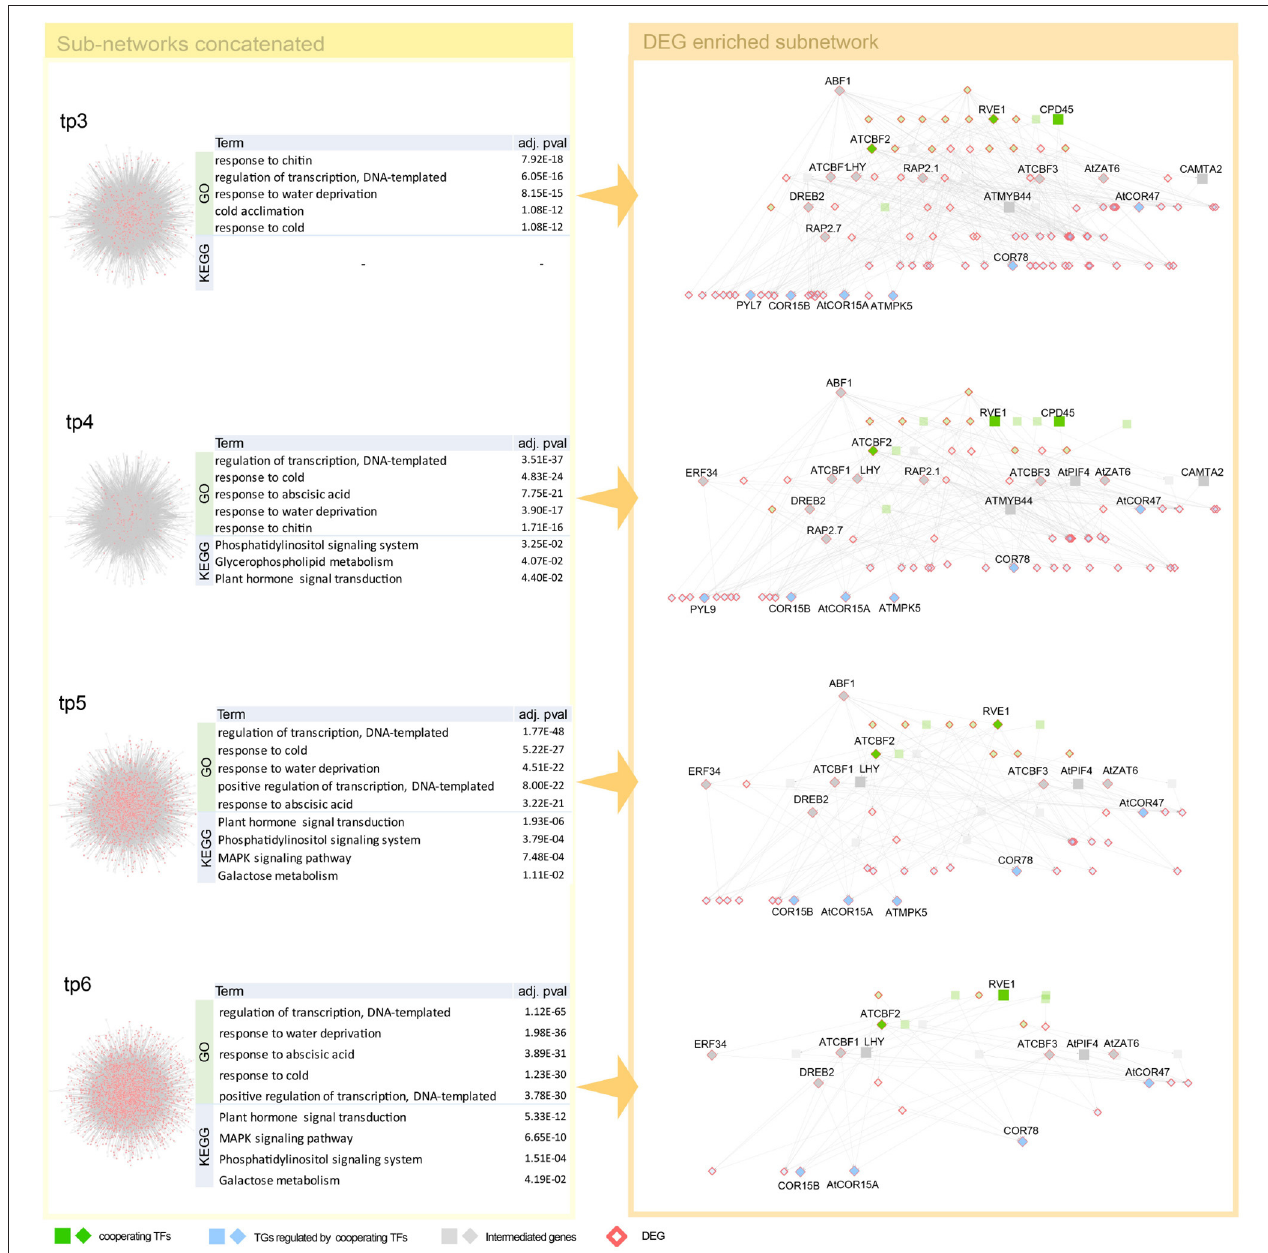
FIGURE 5 | Network dynamics of a gene regulatory network (GRN) sub-network after cold stress over time. Networks in the left panel shows the change in gene–gene relationship, in particular, TF–TG regulation. DEGs are denoted as pink. Four tables in the middle summarize top five most enriched biological pathways with p -value corrected by false discovery rate (FDR) < 0.05. Cold stress related Gene Ontology (GO) terms are enriched in GO enrichment tests with DEGs. The networks in the right panel are dynamics of a TF–TG sub-network that are DEG enriched. TFs were denoted with green nodes. Blue nodes denote TGs and gray nodes denote genes connected to transcription factors (TFs) and target genes (TGs). Square nodes denote DEGs that are detected by limma with FDR < 0.05. We showed GRN from tp3 to tp6, since GRN constructed in tp1 and tp2 is too small because the number of DEGs are too small in tp1 and tp2—41 and 23,